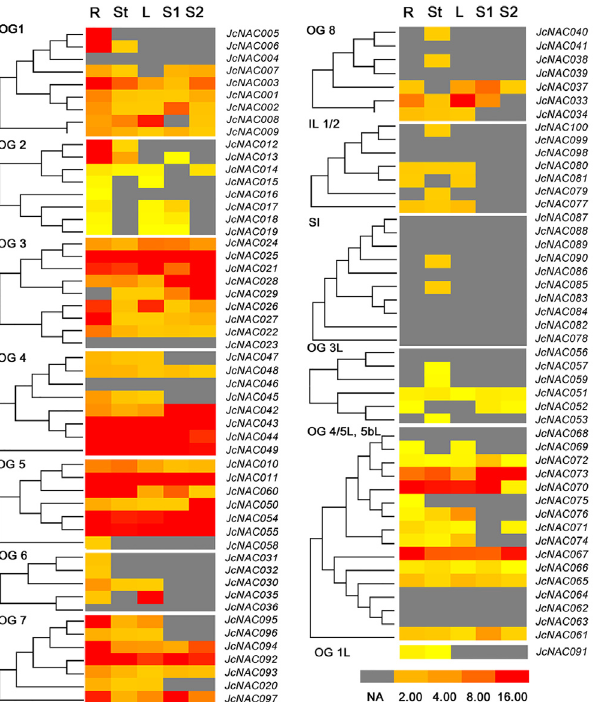
Fig 4. Relative expression levels of JcNAC genes, divided into different orthologous groups. The relative expression levels of all of the JcNAC genes were the average value of 6 biological repeats of digital expression profile tags. NA, not available; R, roots; St, stem cortex; L, leaves; S1, seed 1; S2, seed 2.